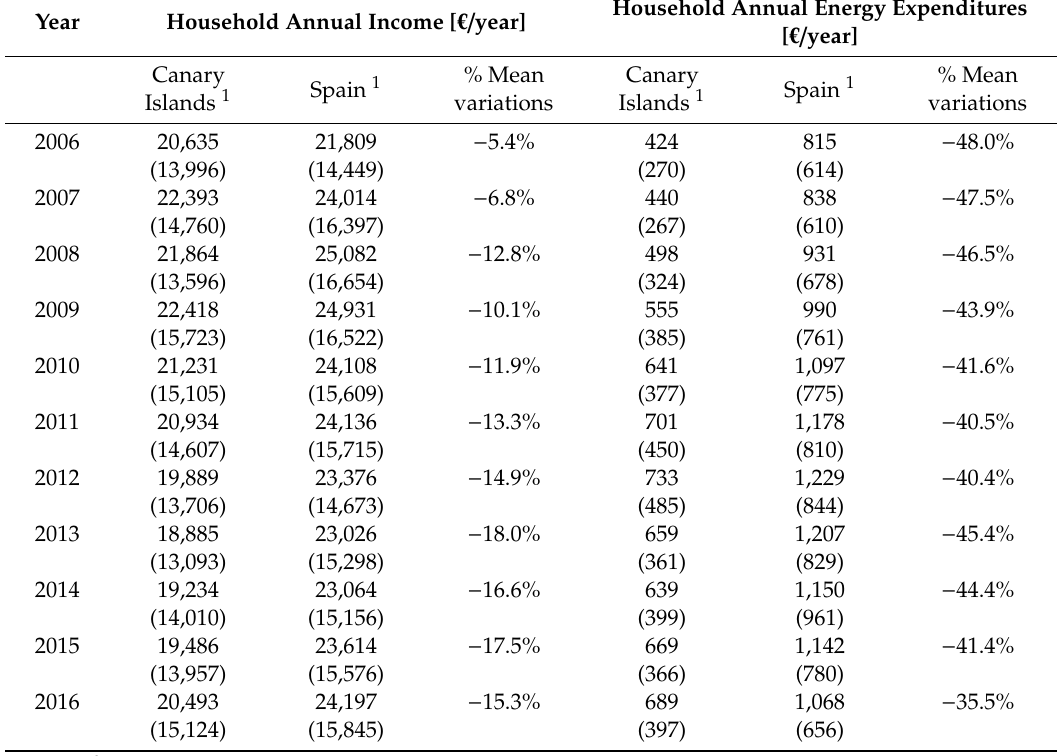
Table 2. Description of income and energy expenditure (Canary Islands – Spain). 2